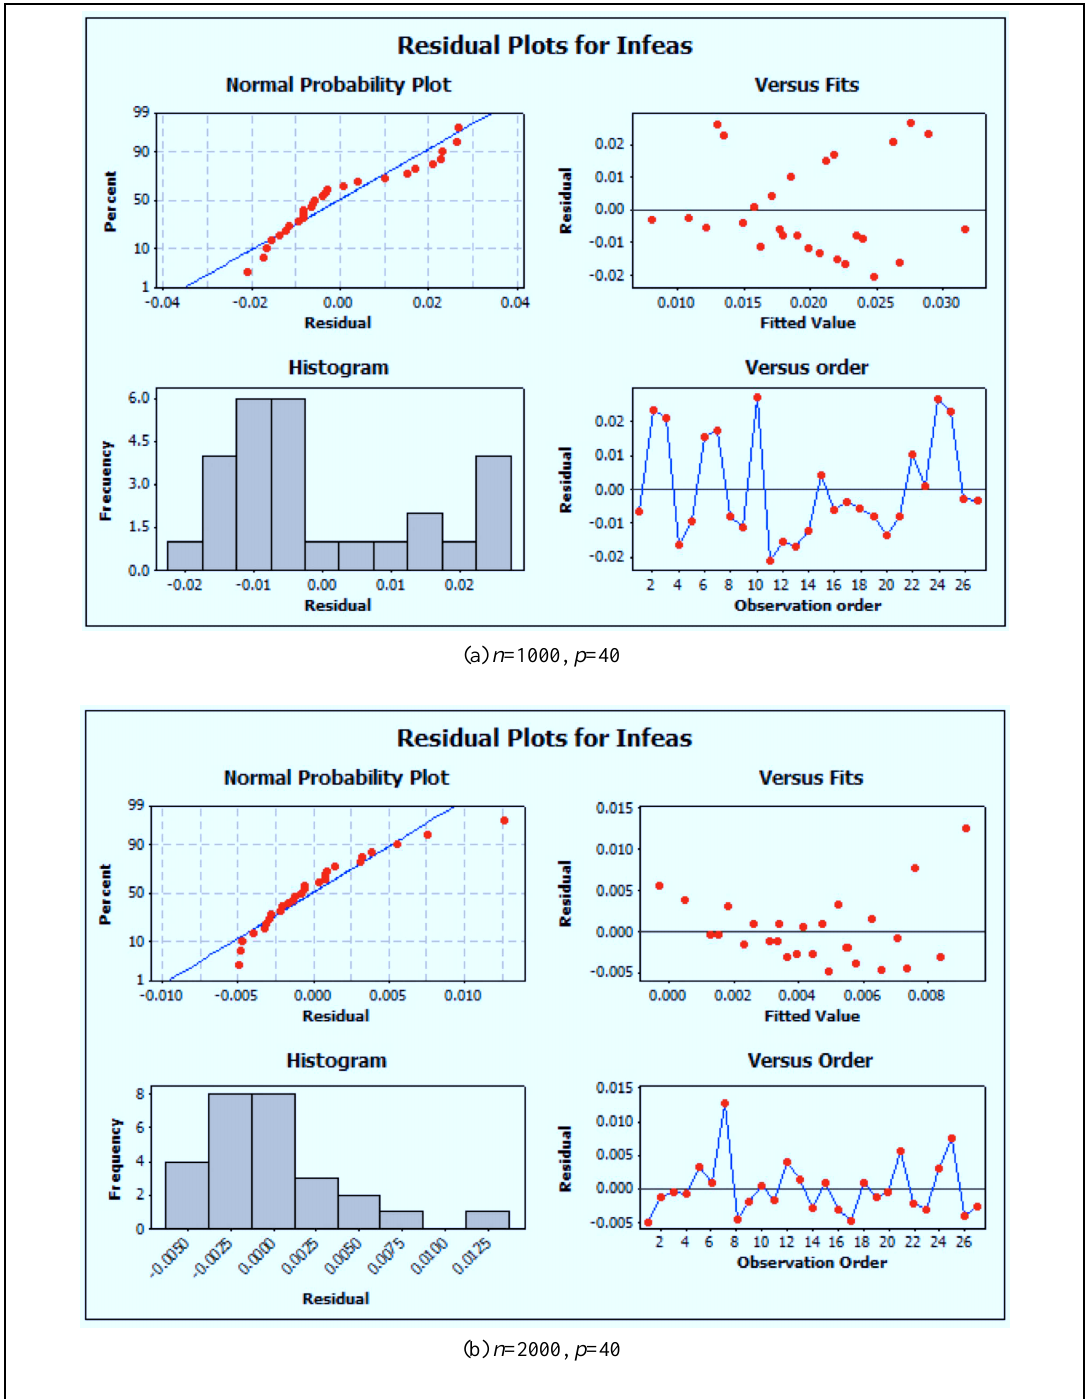
Fig. 7. Residual plots for infeasibility (Infeas) for p =40